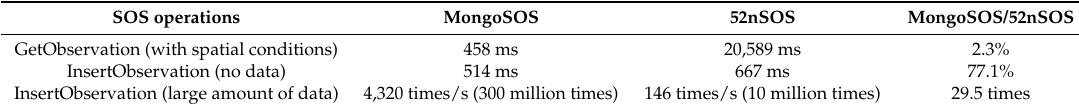
Table 4. Comparison of the average response time between MongoSOS and 52nSOS in the case of 1000 concurrent.